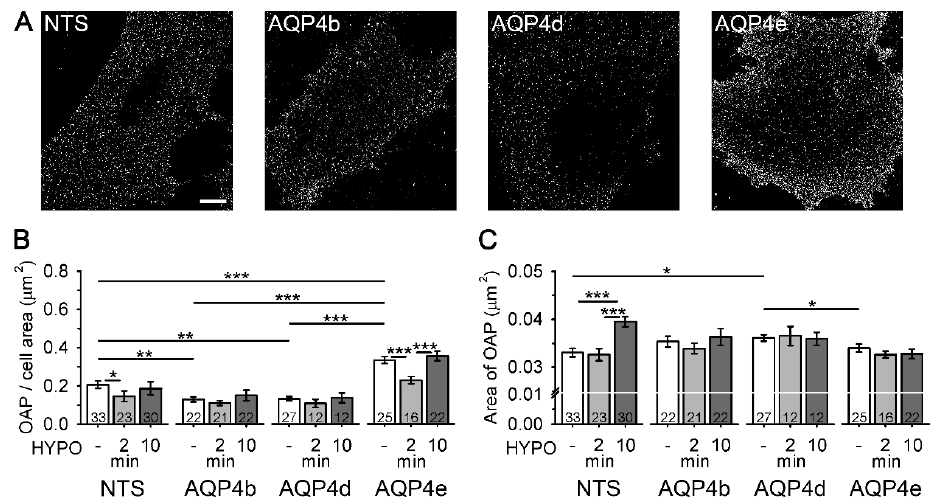
Figure 5. Astrocytes overexpressing AQP4b and AQP4d have a lower density of orthogonal arrays of particles (OAPs). ( A ) SIM micrographs of non-transfected (NTS) astrocytes and astrocytes overexpressing AQP4b, AQP4d, and AQP4e isoforms labeled with NMO-IgG antibodies that tag OAPs (denoted as white dots). Scale bar (for all panels): 10 µm. ( B ) The graph represents the average number of OAPs per cell area (µm 2 ) in NTS astrocytes and in astrocytes overexpressing AQP4b, AQP4d, and AQP4e isoforms. In isoosmotic conditions ( - ), astrocytes overexpressing AQP4b and AQP4d showed a significantly lower density of OAPs from NTS astrocytes ( p = 0.004 and p = 0.005, respectively, Mann–Whitney test), and astrocytes overexpressing AQP4e showed a significantly higher density of OAPs from NTS astrocytes ( p < 0.001, Student's t test). A transient decrease in the density of OAPs in NTS and AQP4e-transfected cells was measured at 2 min of hypoosmotic conditions ( p = 0.02, Kruskal–Wallis test, p < 0.001, Holm–Sidak post hoc test). The density of OAPs in cells overexpressing AQP4b or AQP4d was similar in isoosmotic and hypoosmotic conditions ( p = 0.64 and p = 0.36, Kruskal–Wallis test). ( C ) The graph represents the average area of OAPs in isoosmotic (-) and hypoosmotic (HYPO) conditions. In isoosmotic conditions, astrocytes overexpressing AQP4d had larger OAPs than NTS cells ( p = 0.01, Student's t test) and cells overexpressing AQP4e ( p = 0.03, Mann–Whitney test). In hypoosmotic conditions (10 min HYPO), an increase in the OAP area was measured in NTS cells ( p < 0.001, Holm–Sidak post hoc test). Data represent means ± standard error of the mean from independent experiments equal to the number of animals: 4 (NTS), 3 (AQP4b and AQP4d), and 2 (AQP4e) animals. * p < 0.05, ** p < 0.01, and *** p < 0.001. The numbers in the bars represent the number of cells